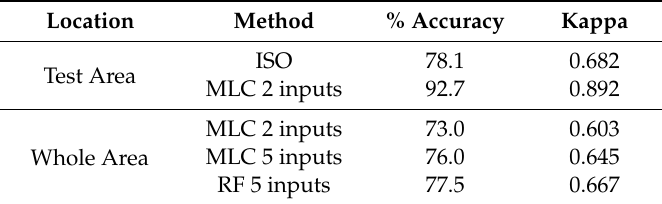
Table 3. Table showing accuracy and kappa coe ffi cient results for each classification method that was conducted on the test area and the whole study